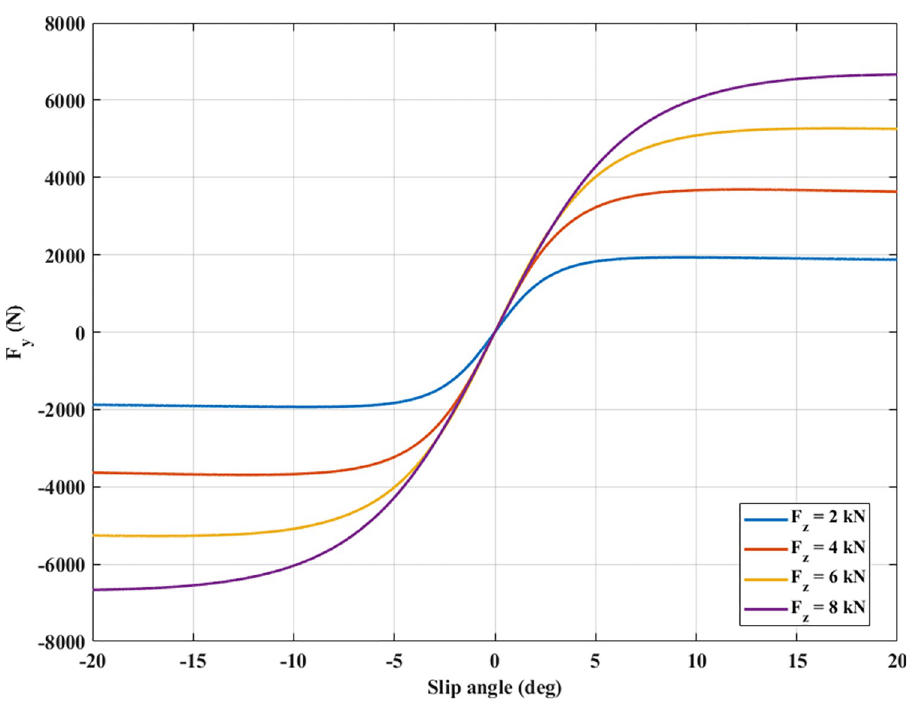
Fig 5. The lateral force.